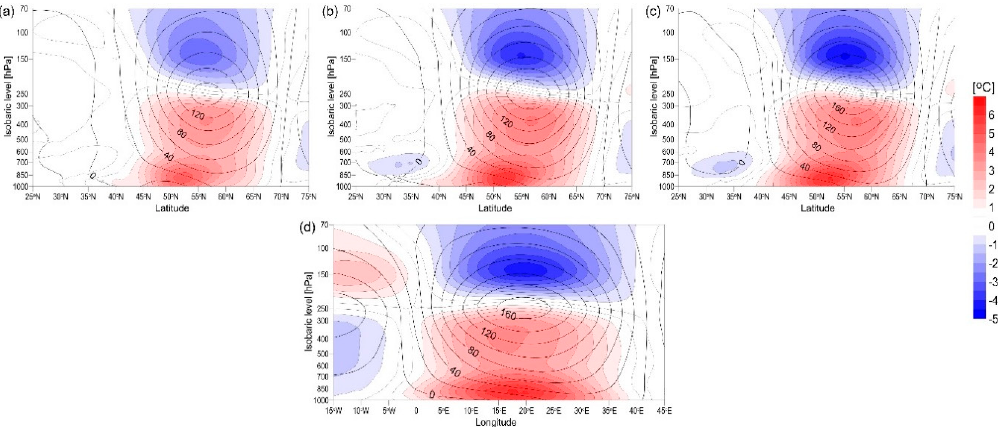
Figure 6. Vertical cross-sections through the troposphere with mean anomalies of heights of isobaric surfaces (black lines) and air temperatures (colour scale) along meridians 10, 15, and 20° E ( a – c ) and a circle of latitude 52.5° N; ( d ) during the analysed waves of hot nights.